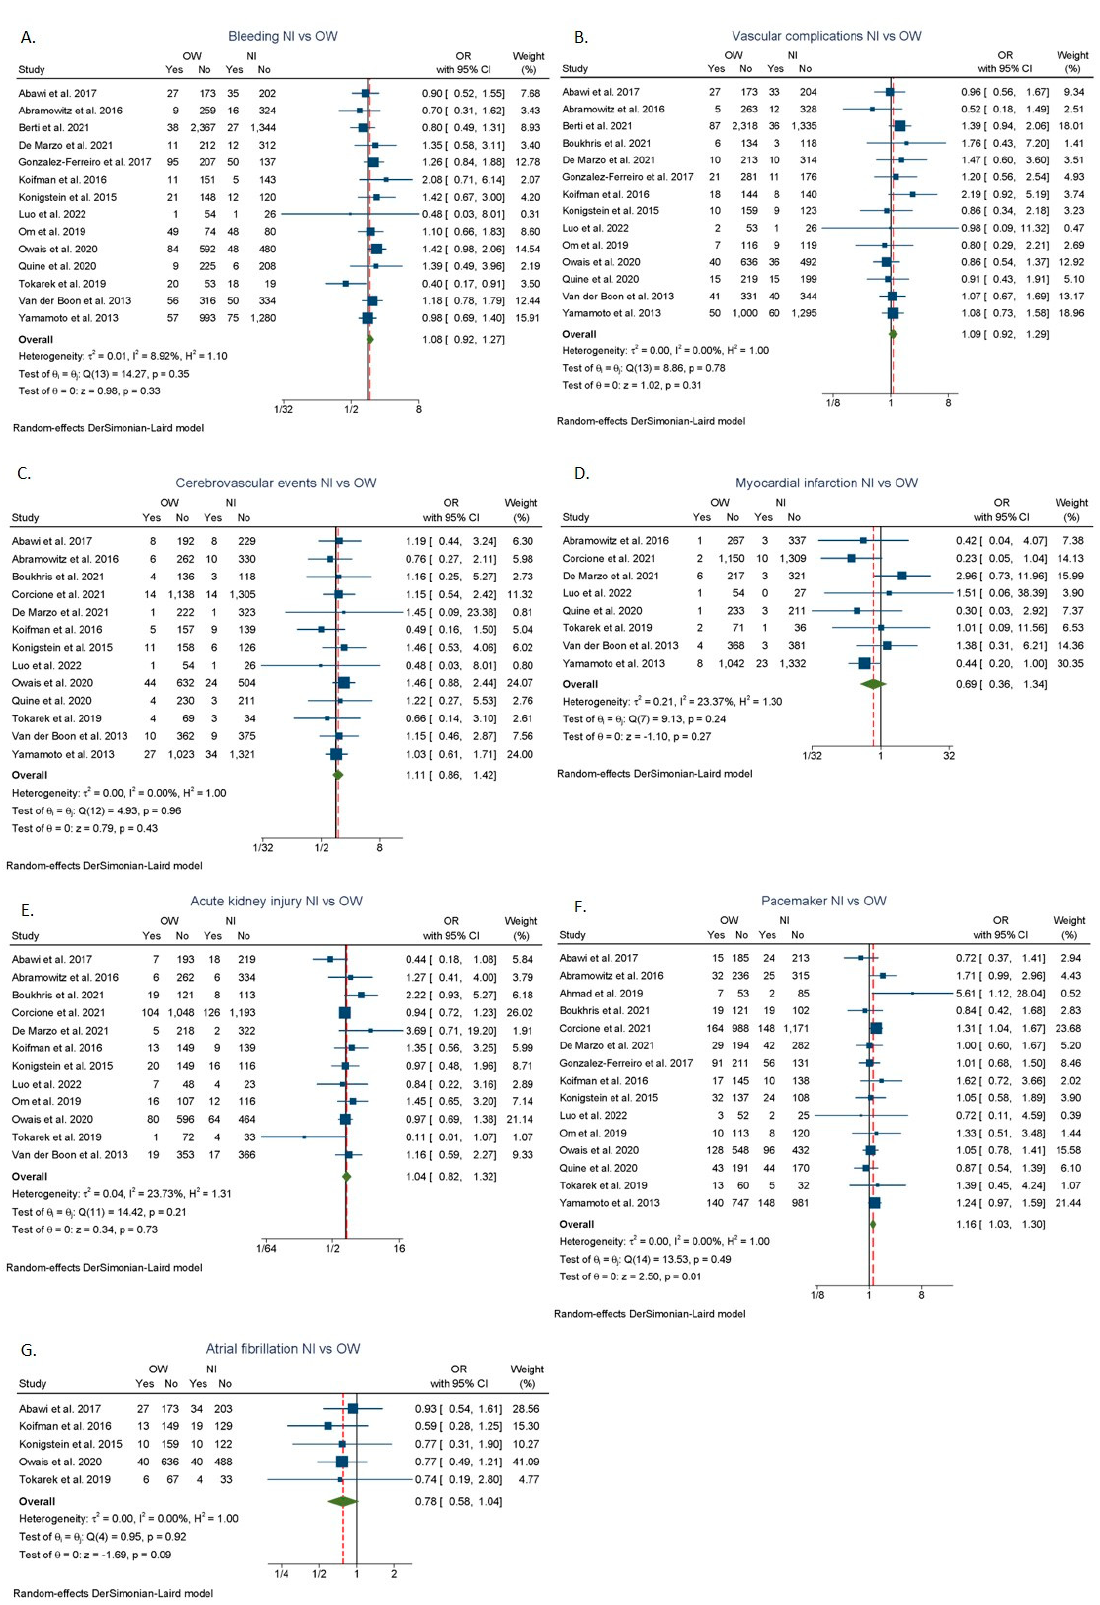
Figure 4. Complication rates after TAVR between normal BMI and overweight categories. ( A ) Major bleeding. ( B ) Major vascular complications. ( C ) Cerebrovascular events. ( D ) Myocardial infarction. ( E ) Acute kidney injury. ( F ) Permanent pacemaker insertion. ( G ) Atrial fibrillation. Nl: normal BMI; OW: overweight; OB: obesity; OR: odds ratio